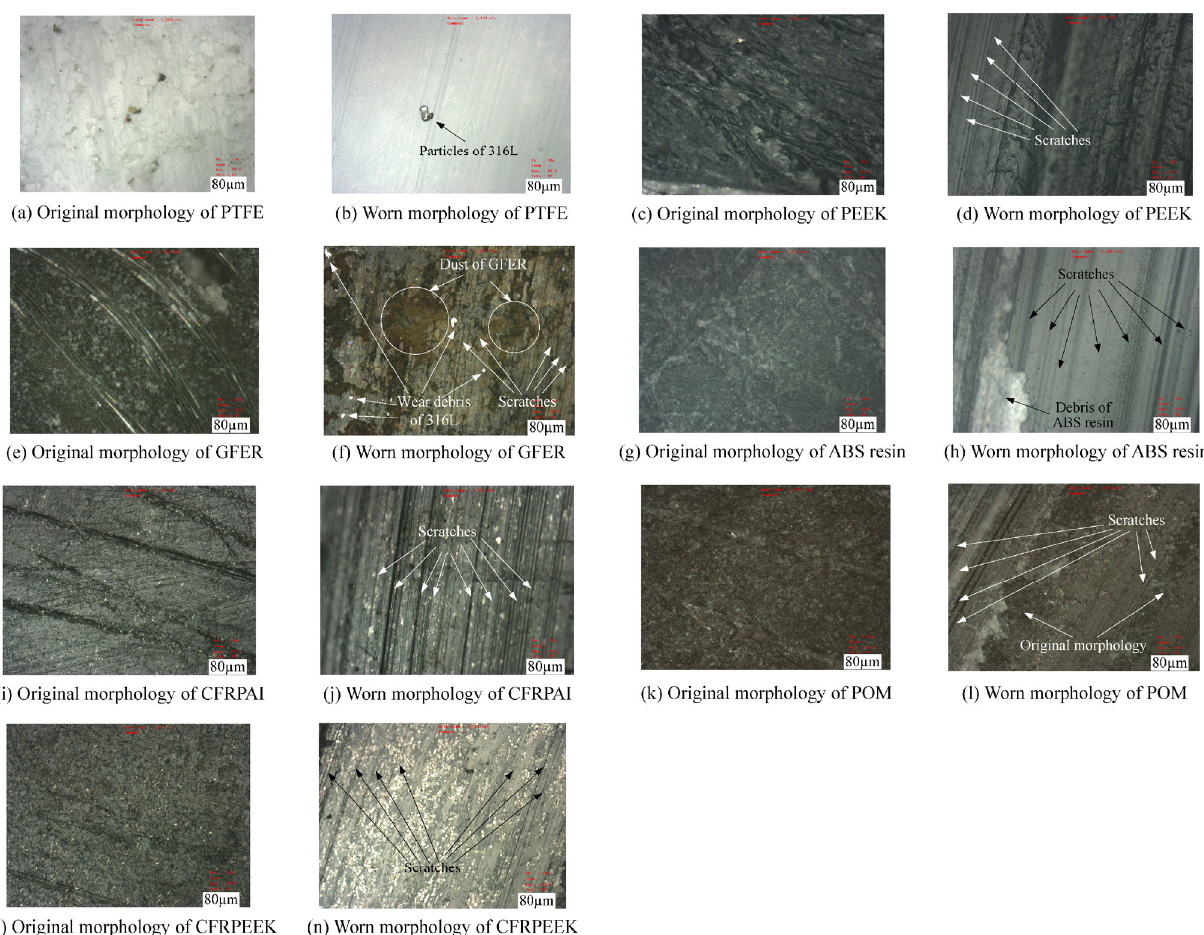
Fig. 5 Original and worn surface morphologies of the various polymer